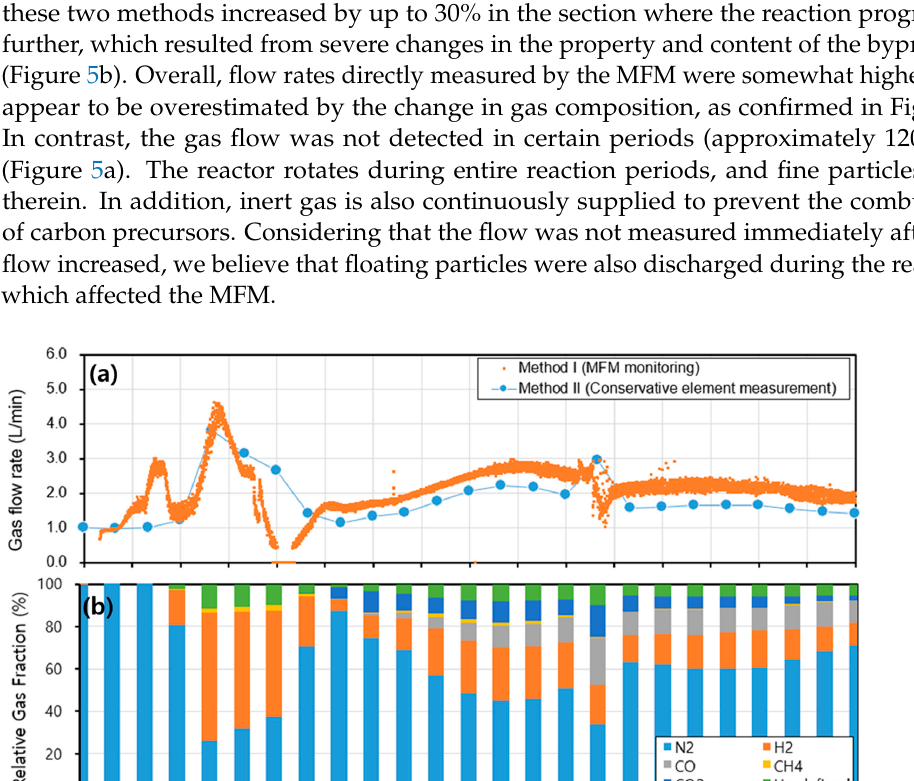
Figure 6. Gas flow relation between Methods I and II with respect to syngas generation. 4. Conclusions In this study, we analyzed the applicability of the conservative element as a reliable method for measuring gas flow rate during a chemical reaction by comparing it with a mechanical device (MFM). The MFM can obtain a reliable flow rate by measuring the mass value of the targeted gas. However, the reliability of the MFM is affected by the various gases produced in the chemical reaction and changes in the gas composition. In contrast, the conservative element is chemically stable, and its concentration in the reaction is de- termined only by physical mixing with the byproduct gases generated. Because the gas flow using the conservative element is not affected by the gas composition and mixing